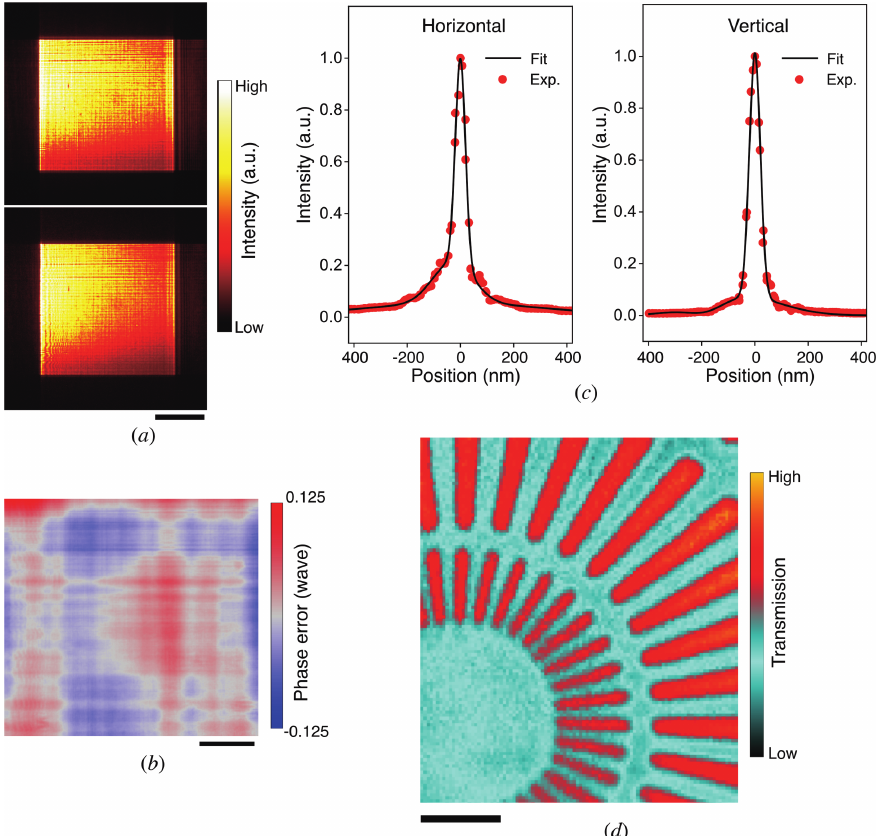
Figure 3 Demonstration results of the nanoprobe scanner. ( a ) Far-field images of the focused X-ray without (top) and with (bottom) the prisms. The scale bar denotes 1 mm. ( b ) The two-dimensional wavefront error of the nanoprobe scanner at the grating plane. The scale bar denotes 50 m m. ( c ) Focusing profiles in the horizontal (left) and vertical (right) directions. The red dots indicate the experimental data. The black solid lines represent the fitting results with the sum of three Gaussian functions. The focus size was 53.2 nm (H) (cid:5) 52.5 nm (V) in FWHM. ( d ) An SXM image obtained using the nanoprobe scanner. A transmission image of the radial test pattern made of 500 nm thick tantalum. The scale bar denotes 0.5 m